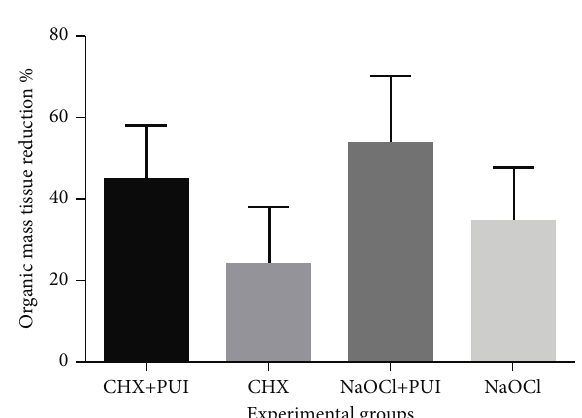
Figure 2: The statistical difference among the four experimental groups.